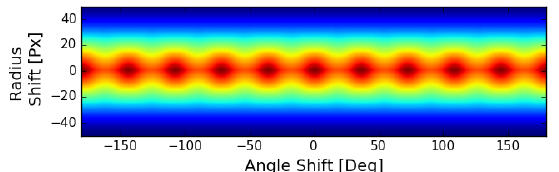
Figure 2: The product of the Wiener-Khinchin method. The im- age shows the values for a shift in both radial and angular direc- tion. Red as the highest and blue as the lowest correlation.